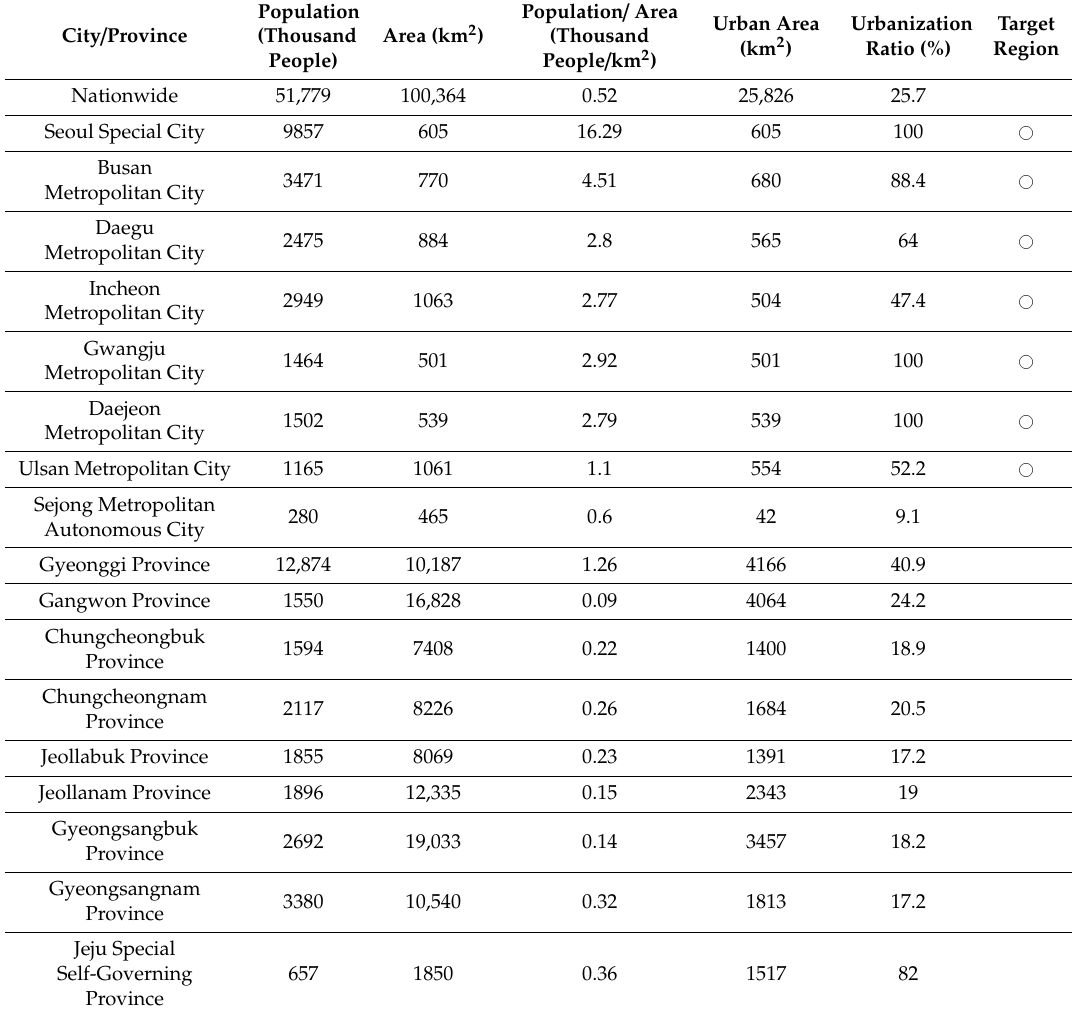
indicates selection as selected urban target